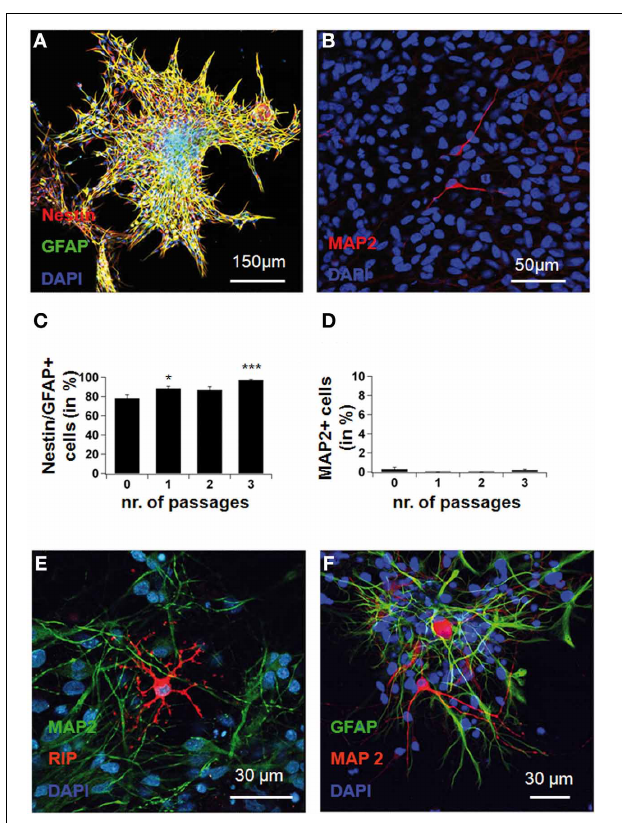
FIGURE A1 | Neural stem cells isolated before differentiation. Cells were expanded in vitro until the formation of free-floating neurospheres. These were plated onto poly-L-lysine, and 2h after plating, were fixed and immunostained for nestin, GFAP and MAP2 after 0, 1, 2, 3, and more passages. In (A) , confocal picture showing nestin and GFAP co-expression in a culture expanded for 3 passages. Note that cells adhere to the culture flask and migrate away from the core of the spheres. In (B) , MAP2ab-staining in the same culture showing that the occurrence of MAP2-positive neurons before differentiation is extremely rare. In (C) , the yield of progenitor cells, double-stained for nestin and GFAP, rose gradually with time in expansion culture, as mature cell types died. In (D) , no significant MAP2-positivity was seen in the system before differentiation. In (E) , confocal microscopy after differentiation in medium rich in cAMP, showing oligodendrocytes (anti-RIP, revealed in red) and neurons (anti-MAP2, revealed in green). In (F) , astrocytes (anti-GFAP, green) and neurons (anti-MAP2ab, red). Red represents AlexaFluor568 and green represents